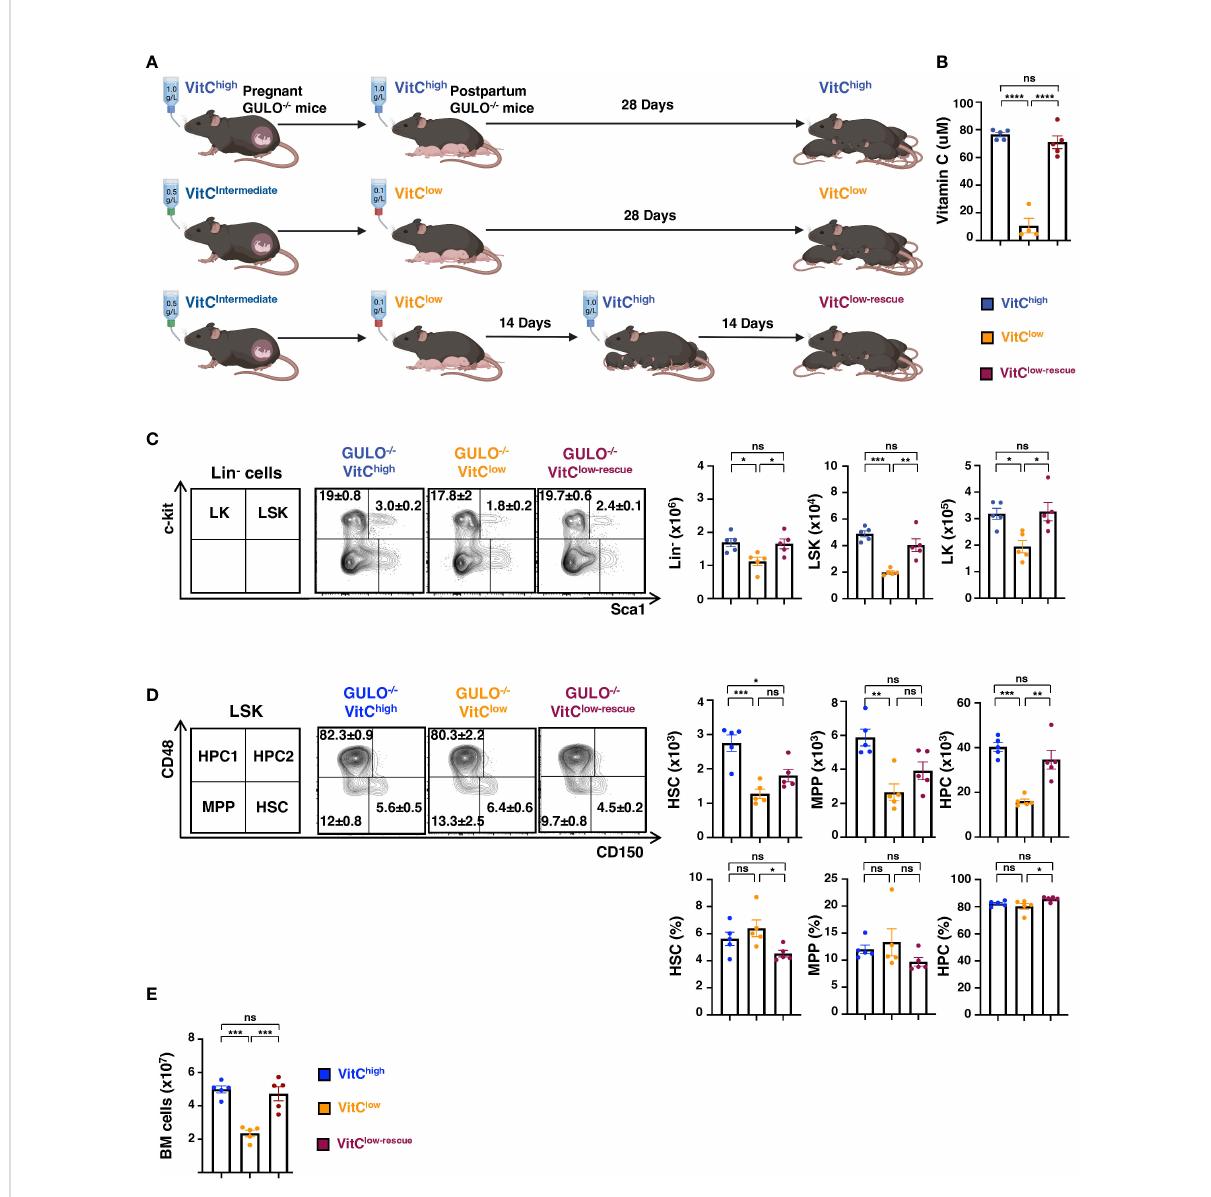
FIGURE 2 Ascorbate rescue results in the increased generation of BM hematopoietic progenitors in GULO -/- pups. (A) Schema illustrating the rescue of ascorbate-de fi cient neonatal GULO -/- mice. Following the birth of pups, dams were either maintained at a high (1g/L, top) or low (0.1g/L, middle) dose of vitamin C for 28 days. For rescue experiments, GULO -/- pups maintained on low dose VitC (0.1g/L) were switched to a high dose (1g/L) at 14 days of life and mice were evaluated at day 28 (VitC low-rescue , bottom). (B) Plasma VitC concentrations were measured in all 3 groups at day 28 and means ± SEM are presented (n=4-5 per group). (C) Representative c-Kit/Sca1 plots of Lin - cells are shown (left) and absolute numbers ± SEM of Lin - , LSK, and LK progenitors are presented (n=5 mice per group). (D) Gating strategy used to de fi ne HSC (CD150 + CD48 - LSK), MPP (CD150 - CD48 - LSK) and HPC (CD150 +/- CD48 + LSK) populations (36) together with quanti fi cations and percentages of each subset ± SEM are presented (n=5 mice per group). (E) Mean BM cellularity ± SEM in each condition (n=5 per group). Statistical analyses were performed using a one-way ANOVA (Tukey ’ s test). *p < 0.05; **p < 0.01; ***p < 0.001; ****p < 0.0001; ns, not signi fi